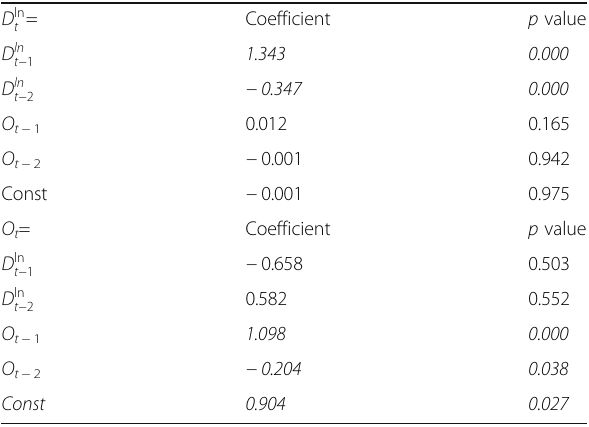
Table 8 Coefficients ’ estimations of a VAR (2) model between the D ln and O t for all phases. Top: model for D ln t for O t . Italics: significant results with 5% level